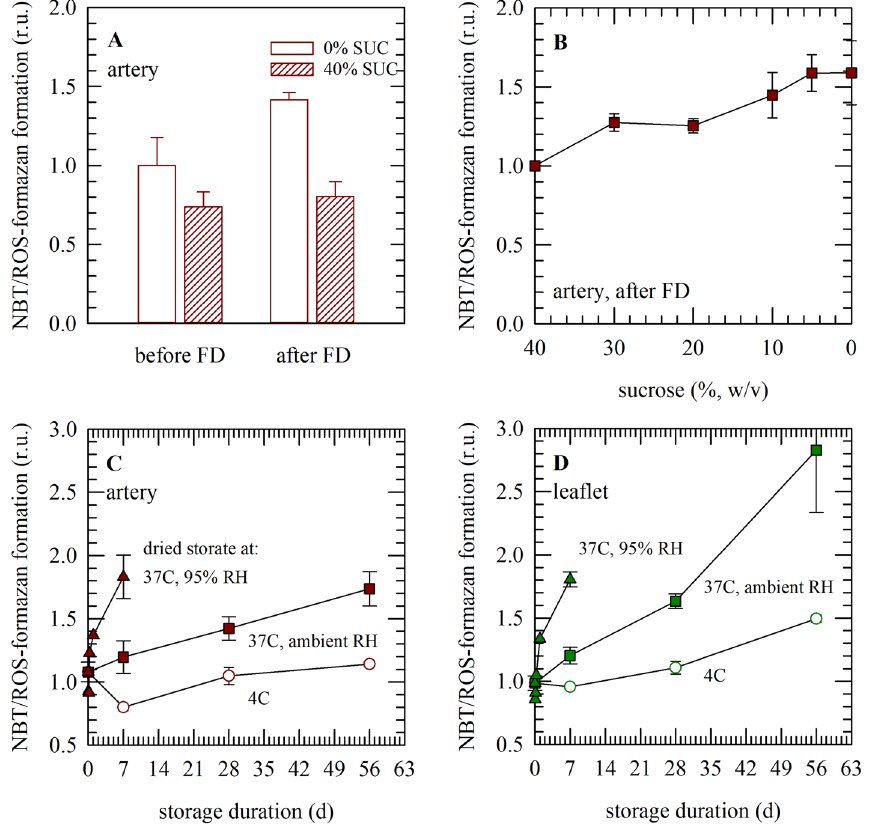
Figure 2. Quantification of accumulation of reactive oxygen species in decellularized and freeze-dried heart valve tissue, analyzed via following NBT-formazan formation. The intensity of blue/purple staining, depicted in Fig. 1, was quantified via image analysis and normalized towards initial/reference values obtained with each data set. This was done for artery tissue, before and directly after freeze-drying with 40% sucrose ( A ) as well as after freeze-drying with sucrose concentrations ranging from 40 to 0% ( B ). Furthermore, both for artery ( C ) and leaflet tissue ( D ), specimens were analyzed during dried storage at 4 °C (circle symbols) and 37 °C (square symbols), under ambient RH, and during storage at high RH at 37 °C (triangle symbols). Mean values ± standard deviations are presented, determined from three to six tissue